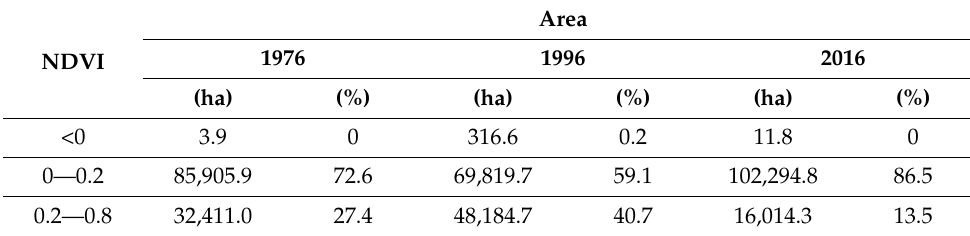
Figure 7. NDVI maps for the Merguellil watershed during ( a ) 1976, ( b ) 1996, and ( c ) 2016. Table 7. Total area of NDVI index classes for 1976, 1996, and